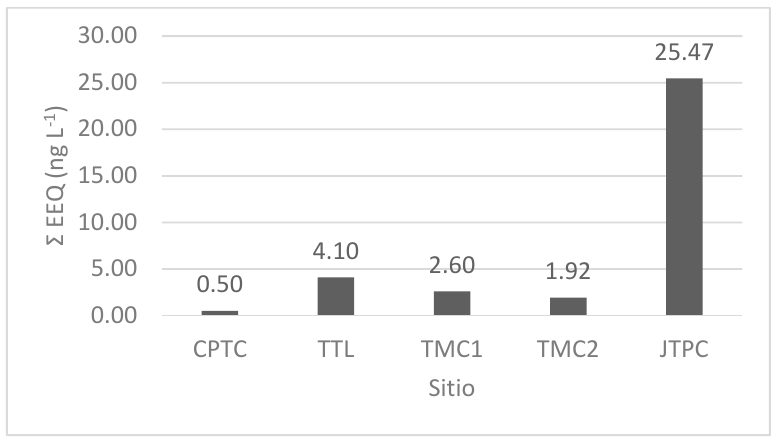
Figure 3. Total EEQ value ( Σ EEQ ng·L − 1 ) in water for each site.